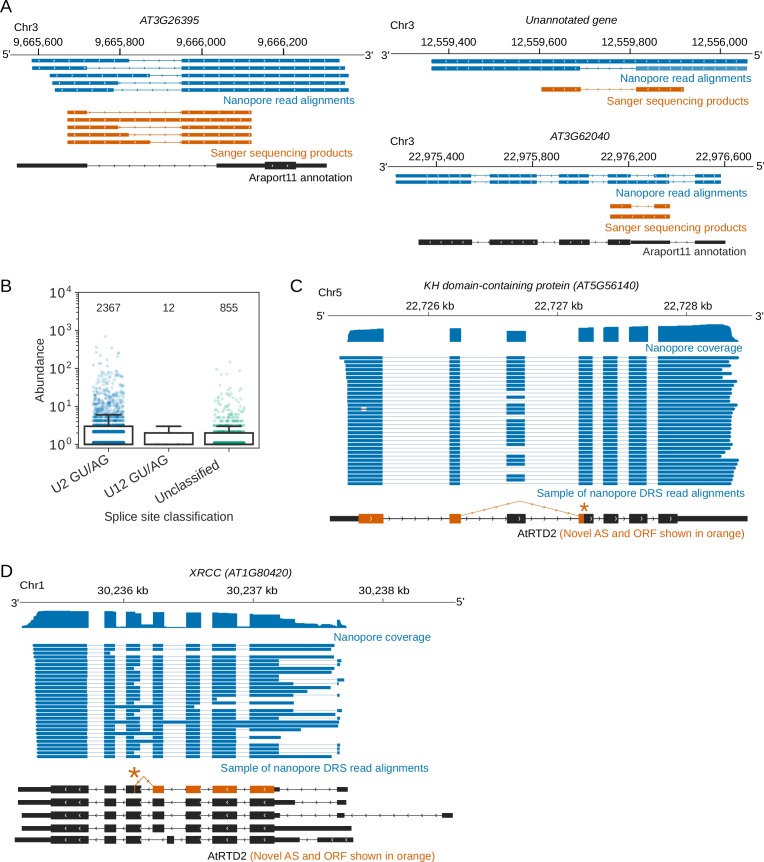
Patterns of splicing revealed using nanopore DRS.(A) Nanopore DRS novel splicing events can be validated using RT-PCR. Blue, RNA isoforms found using nanopore DRS; orange, Sanger sequencing products obtained using RT-PCR; black, RNA Araport11 annotation. (B) Splice junction classification of unannotated GU/AG splice sites found in error-corrected nanopore DRS data that also have Illumina support. Counts are plotted in log10 scale and the exact number of splice junctions in each set is indicated. (C) A novel exon skipping event at exon 3 of KH domain-containing protein AT5G56140, identified by nanopore DRS, leads to a frameshift resulting in a premature termination codon in exon 4 (orange asterisk). Blue track, nanopore DRS cleavage, blue, nanopore DRS read alignments; black, AtRTD2 annotation; orange, full novel open reading frame (ORF). (D) A selection of novel alternative acceptor site at XRCC (AT1G80420), identified in nanopore DRS, leads to a frameshift resulting in a premature termination codon in exon 6 (orange asterisk). Blue track, nanopore DRS cleavage, blue, nanopore DRS read alignments; black, AtRTD2 annotation; orange, full novel open reading frame (ORF).Figure 4—figure supplement 1—source data 1.Sanger sequencing products from novel nanopore DRS splicing events – Figure 4—figure supplement 1A.